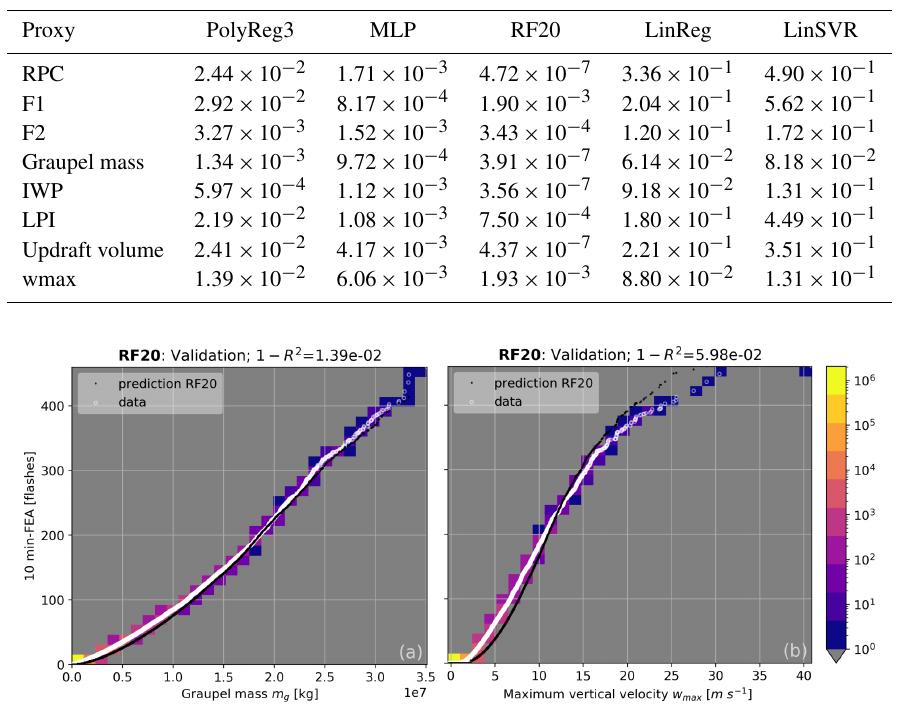
Figure 8. Sorted distribution for the validation set of the observed FEA versus the simulated graupel mass (a) and maximum vertical velocity (b) in white. Black dots correspond to the FEA predicted by the RF20